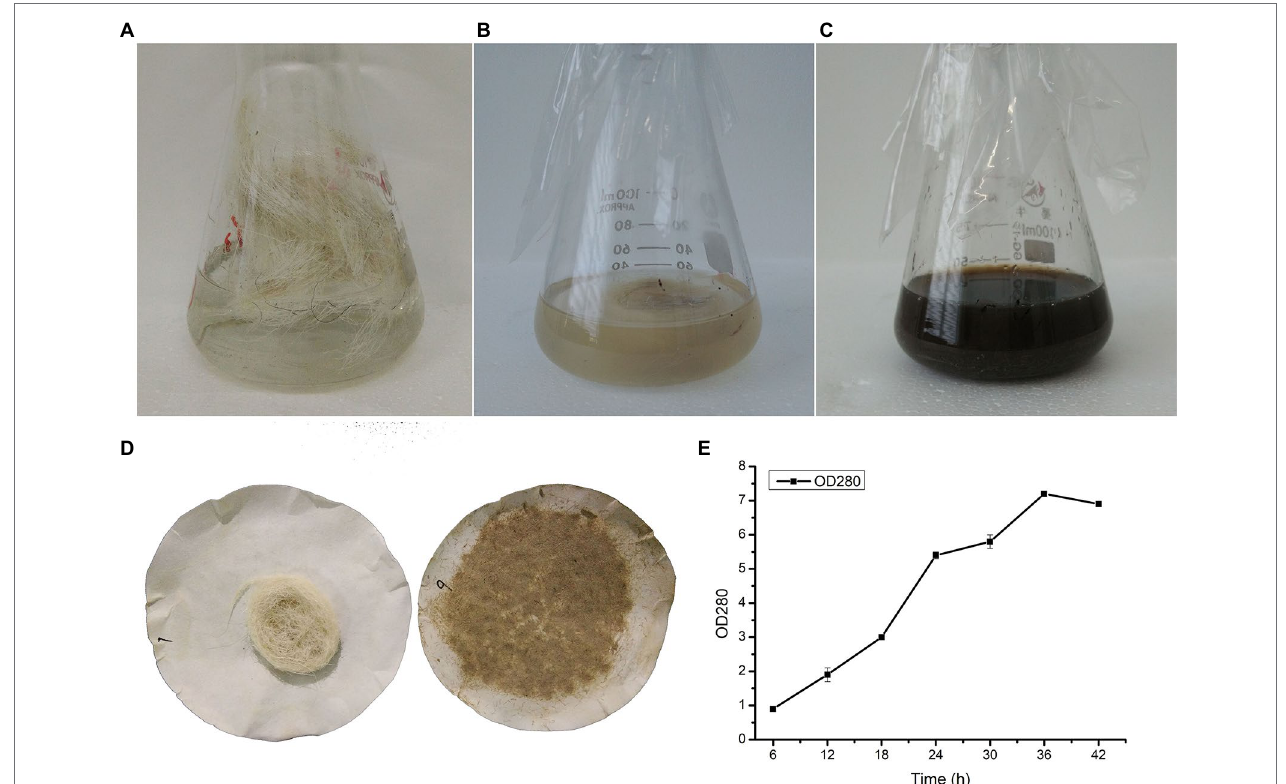
FIGURE 1 | Wool fermentation by Lysobacter brunescens YQ20. (A) Fermentation medium with unprocessed wool as a substrate, without sterilization. (B) Fermentation medium with unprocessed wool as a substrate, sterilization. (C) Unprocessed wool after fermentation. (D) Filter residues without and with fermentation. (E) Time course study on amino acid production during